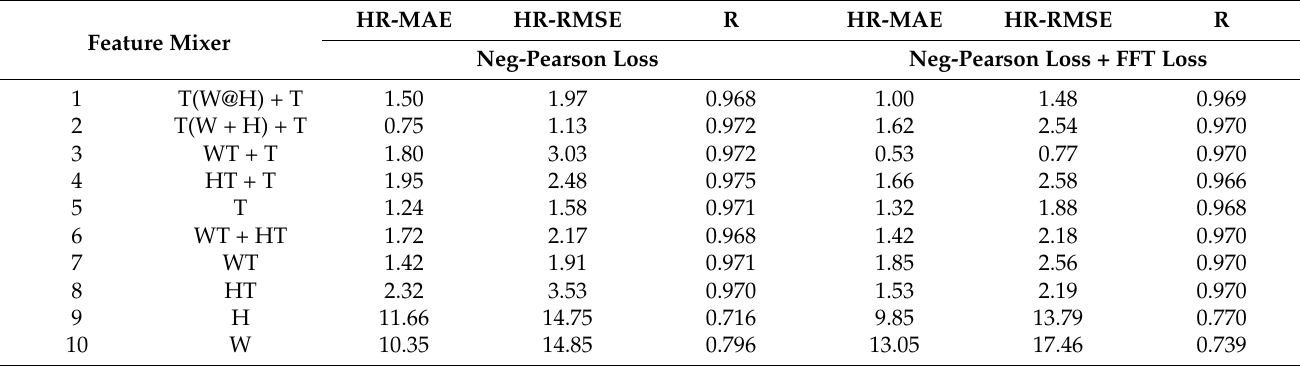
Table 6. Evaluation results for 10 feature mixers using the UBFC